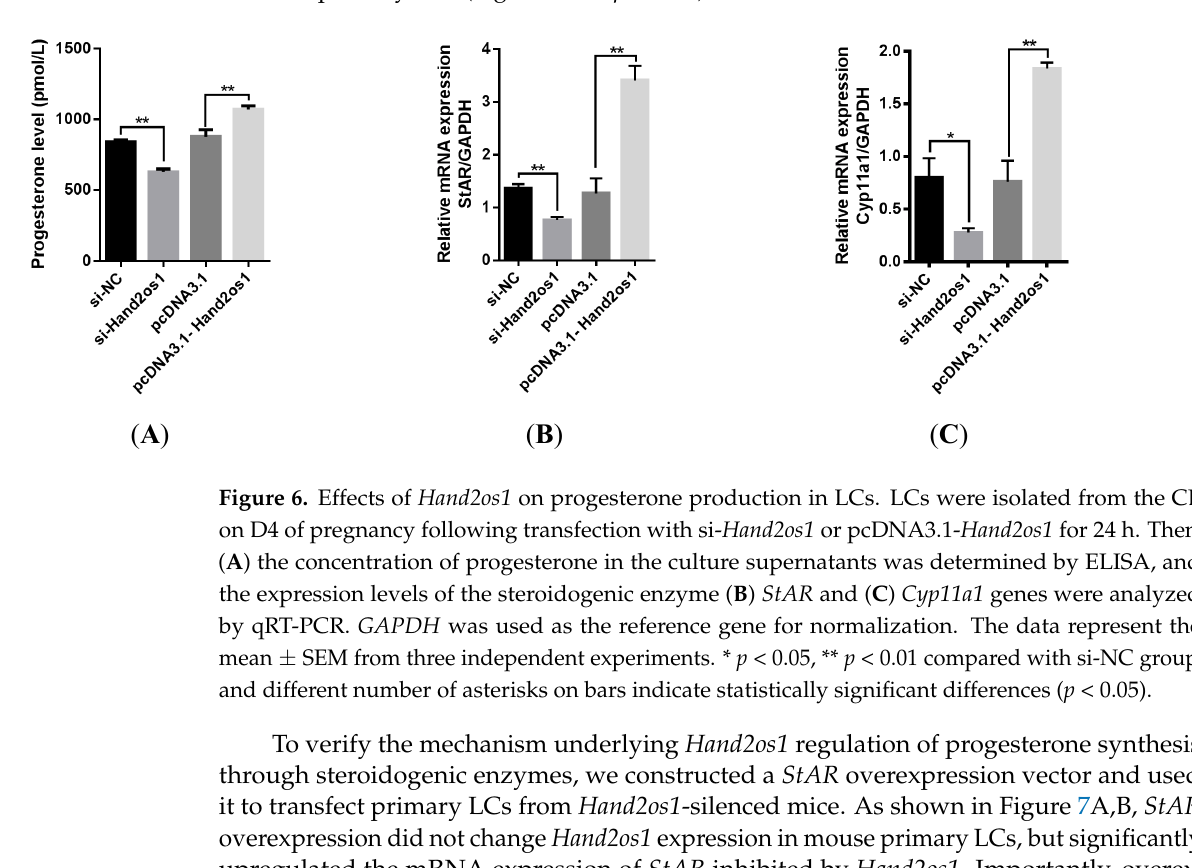
or increased after the silencing or overexpression, respectively, of the Hand2os1 gene in cultured primary LCs (Figure 6B,C, p < 0.05).